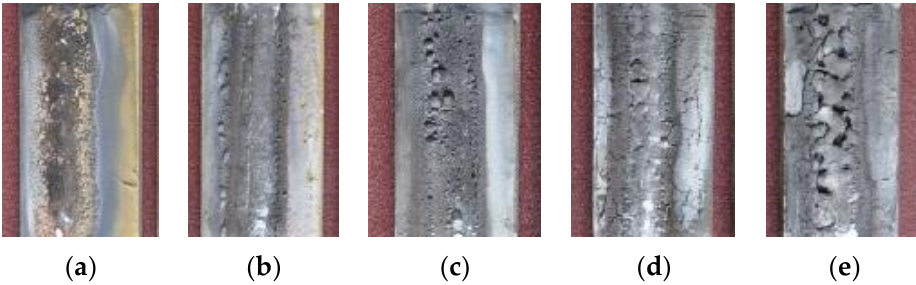
Figure 5. Morphology of cladding layer: ( a ) 100 wt.% CuZn40; ( b ) 30 wt.% CuZn40 + 70 wt.% WC; ( c ) 50 wt.% CuZn40 + 50 wt.% WC; ( d ) 30 wt.% CuZn40 + 70 wt.% WC; ( e ) 20 wt.% CuZn40 + 80 wt.% WC.